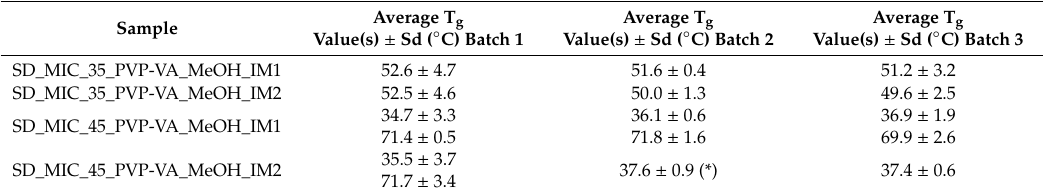
Table 5. Repeatability of the surface coating procedure. Average T g values ± sd for MIC-PVP-VA spray dried powder, using the intermittent spraying procedures IM1 (20 s–20 s) and IM 2 (20 s–40 s). Two T g values ± sd are reported for amorphous-amorphous phase separated